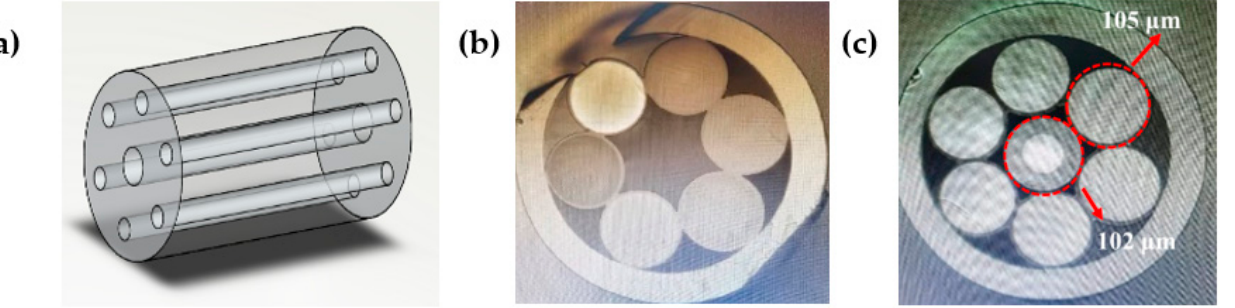
Figure 3. ( a ) The structure diagram of the seven-hole glass tube; microscopic images of the TFB before ( b ) and after ( c ) the central fiber inserted.